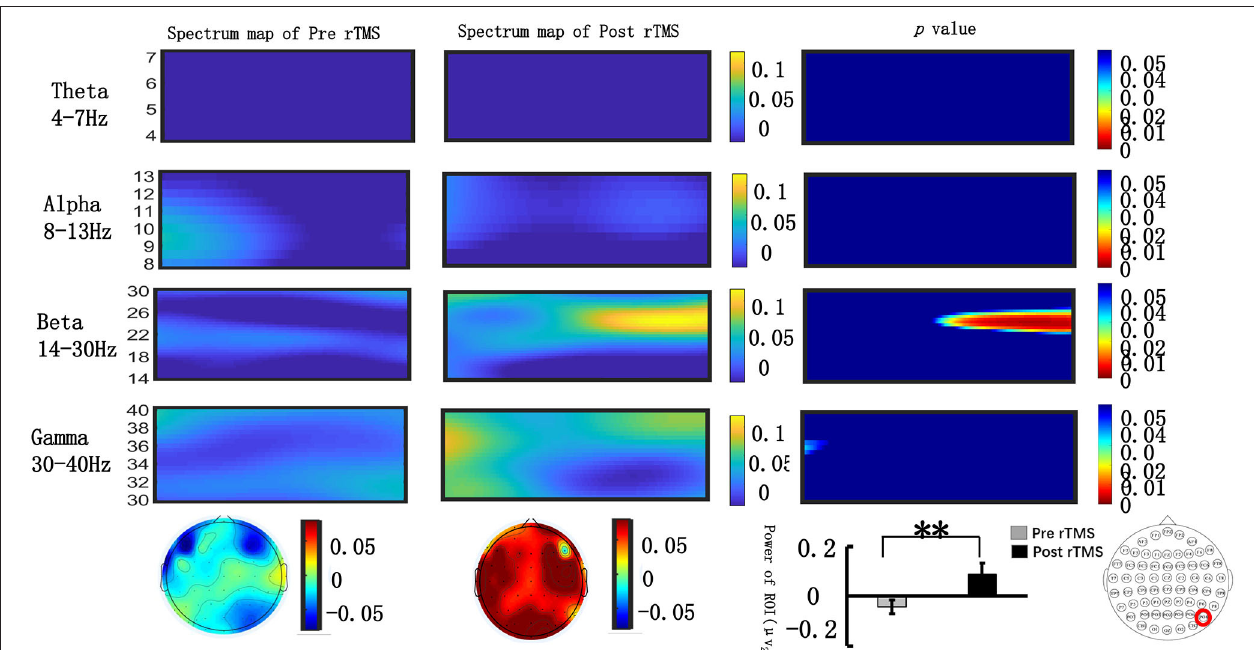
FIGURE 5 | Grand average time–frequency distribution (TFD) and β oscillation scalp topographies over the occipital lobe during the N2PC time window pre- and post-repeated transcranial magnetic stimulation (rTMS). The time–frequency distribution over the occipital lobe (PO8) in the θ (4–7Hz), α (8–13Hz), β (13–30Hz), and γ bands (30–40Hz) during the CDA time window (400–600ms); the spectrum maps pre- and post-sTMS are listed separately in the first and second line. The third line represents the p -value of every frequency point and time point of spectrum power pre- and post-sTMS. Significant differences were found in the β (22–26Hz) oscillation scalp topographies over the occipital lobe during the CDA time window (510–600ms); bar graph differences of the pre- and post-time periods are shown at the bottom of figure. ** p < 0.01.